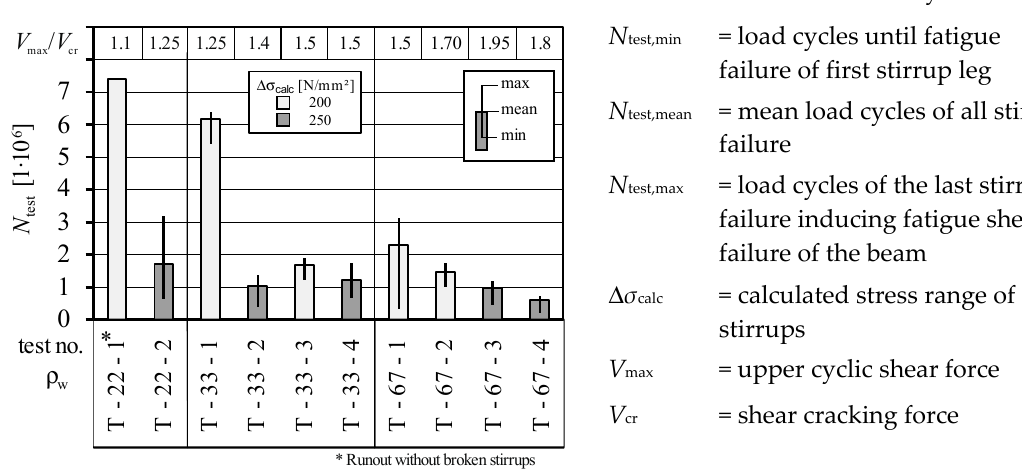
Figure 7. Resisted number of cycles until fatigue failure N test of the shear reinforcement.